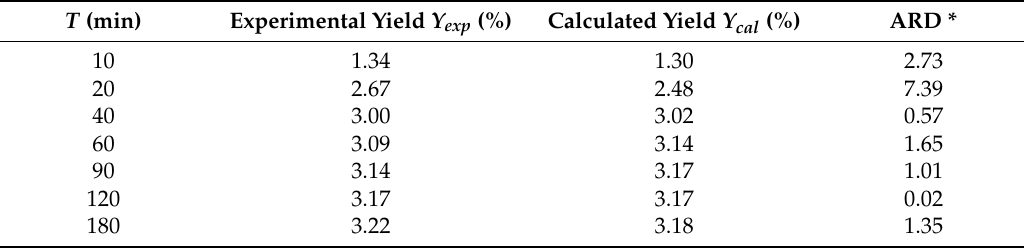
Table 3. BIC model fitting of Mortiño SFE experimental kinetics at 30 MPa and 313 K in a small-scale extraction cell (273 cm 3 ).